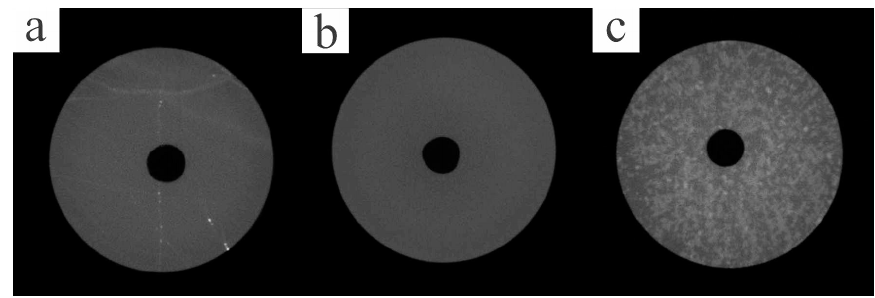
Figure 4. CT scanning images of sandstone ( a ); shale ( b ); and granite ( c ) before hydraulic fracturing.